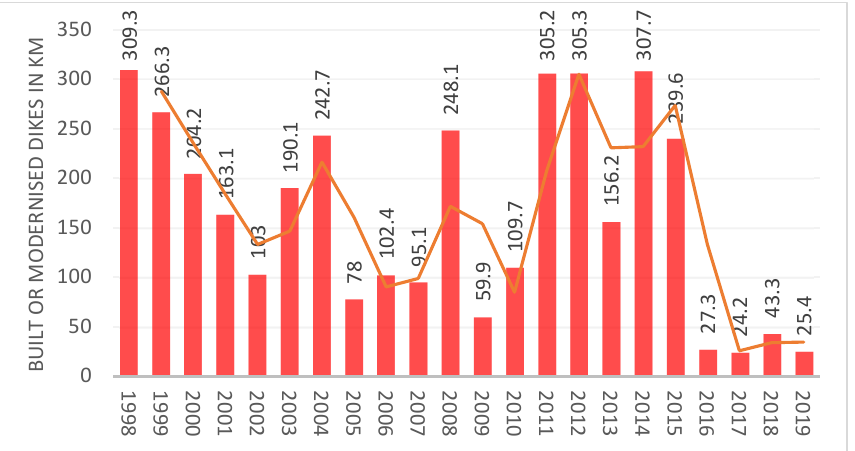
Figure 1. Built and modernised flood dikes (in kilometres) (source: own elaboration based on Central Statistical Office data).